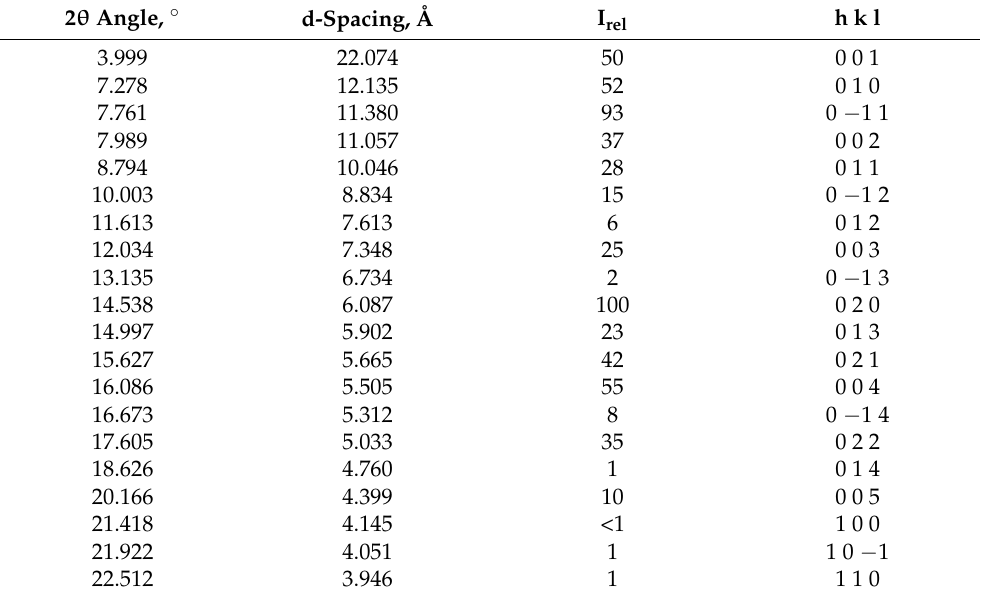
Table 2. List of observed 2 θ angles, d-spacings, and relative intensities, jointly with reflection indices, for Eltrombopag Form I.